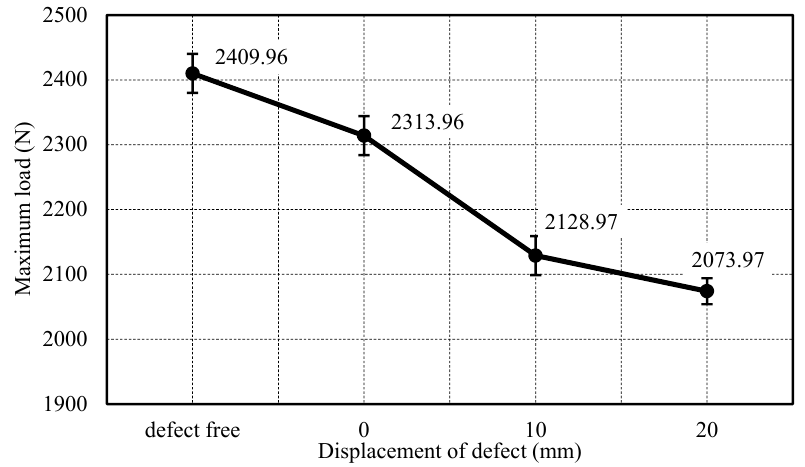
Figure 9. Effect of the defect’s location on the peak load for gray samples. Figure 9. E ff ect of the defect’s location on the peak load for gray samples.